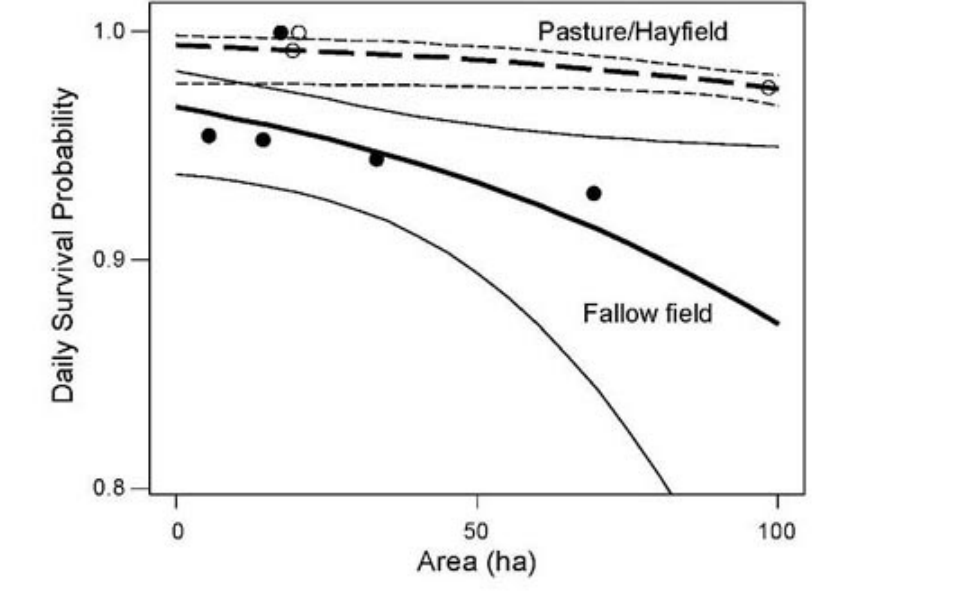
Fig. 1. Daily survival probabilities for obligate grassland bird nests at Iroquois National Wildlife Refuge in fallow fields (solid line, closed circles) and pasture/hayfields (dashed line, open circles). The lines are the predictions from the top logistic exposure model, with 95% confidence intervals. The circles are field-specific Mayfield estimates. The sixth fallow field, with area 40 ha and estimated daily survival rate of 0, is not shown because the sample size, 1 nest, was so